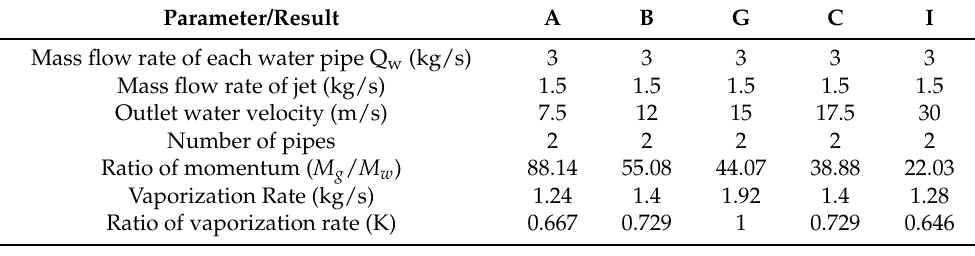
Table 3. Computational results.